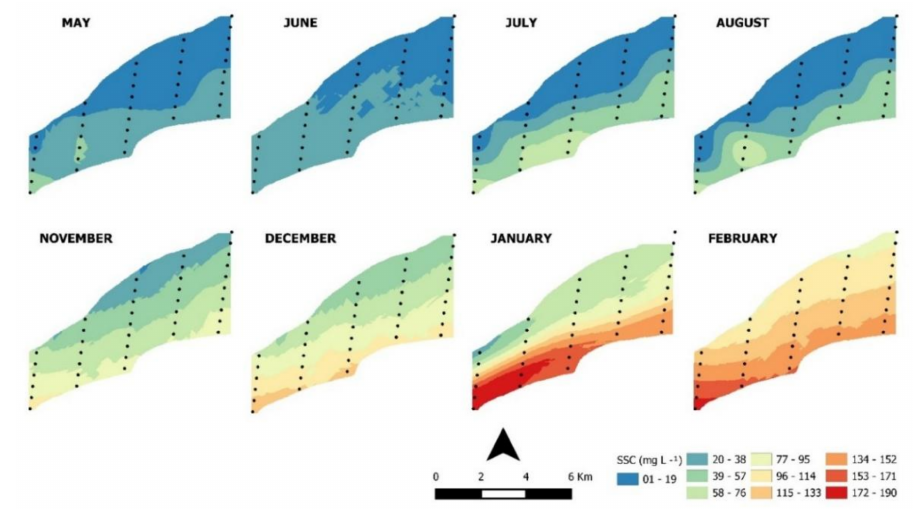
Figure 2. Temporal variation of Suspended Sediment Concentrations (SSC) by interpolation of monthly SSC grid point